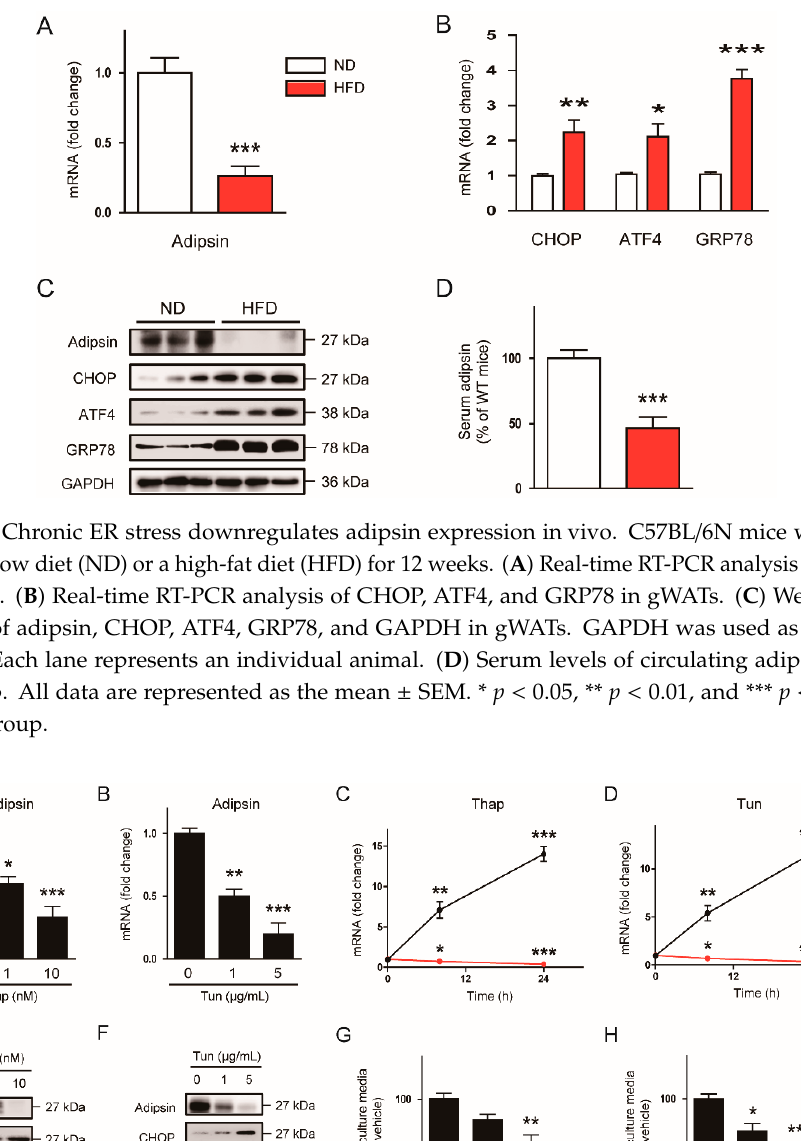
Figure 4. ER stress downregulates adipsin expression in vitro. Mature 3T3-L1 adipocytes were treated with thapsigargin (Thap; 0, 1, or 10 nM) or tunicamycin (Tun; 0, 1, or 5 μ g/mL) for 0, 12, or 24 h. ( A ) Dose-dependent effects of Thap on adipsin mRNA at 24 h. ( B ) Dose-dependent effects of Tun on adipsin mRNA at 24 h. (C ) Time-dependent effects of Thap on mRNA of adipsin and GRP78. (D ) Time-dependent effects of Tun on mRNA of adipsin and GRP78. ( E ) Dose-dependent effects of Thap on protein levels of adipsin, CHOP, ATF4, GRP78, and GAPDH. GAPDH was used as a loading control. ( F ) Dose-dependent e ff ects of Tun on protein levels of adipsin, CHOP, ATF4, GRP78, and GAPDH. GAPDH was used as a loading control. ( G ) Levels of adipsin secreted into culture media in Thap-treated cells. ( H ) Levels of adipsin secreted into culture media in Tun-treated cells. All data are represented as the mean ± SEM. * p < 0.05, ** p < 0.01, and *** p < 0.001 vs. non-treated